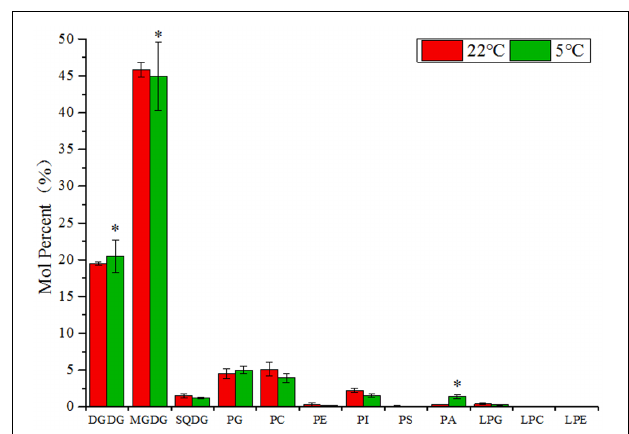
FIGURE 1 | Changes of glycerolipids species in maize leaves under low temperature (5 ◦ C) in comparison to room temperature (22 ◦ C). Values (mol %) are means 5 ± standard deviation (SD) ( n = 5). MGDG, monogalactosyldiacylglycerol; DGDG, digalactosyldiacylglycerol; SQDG, sulfoquinovosyldiacylglycerol; PG, phosphatidylglycerol; PC, phosphatidylcholine; PE, phosphatidylethanolamine; LPG, Lyso-PC; LPC, Lyso-PC; LPA, Lyso-PC. “ ∗ ” indicated that the value was significantly different from the control ( P <